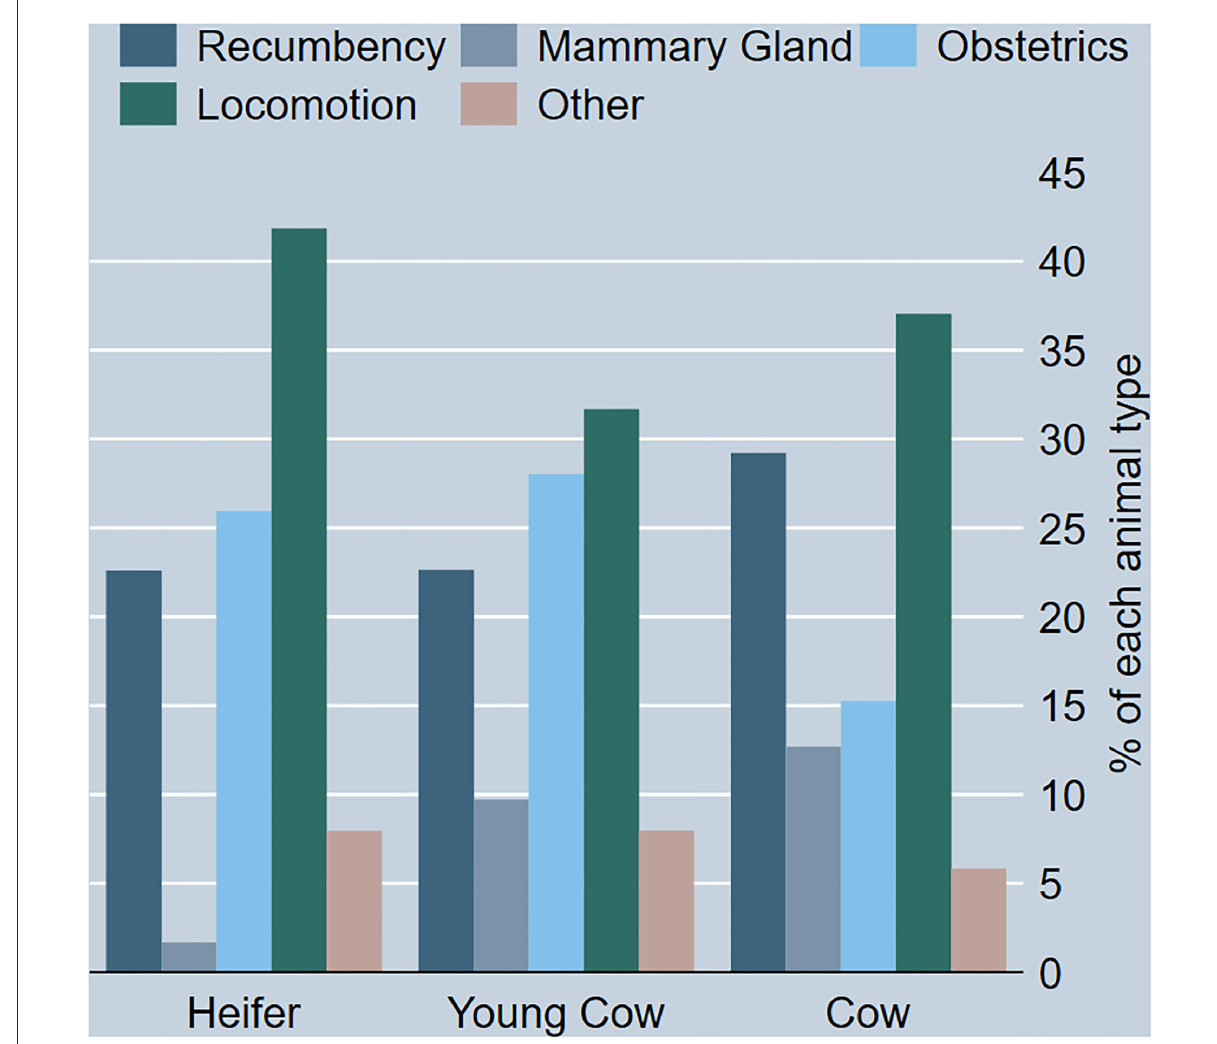
FIGURE2 Bar graph showing the proportion of each reason for OFES for 3 animal types; Heifer, Young Cow and Cow n =